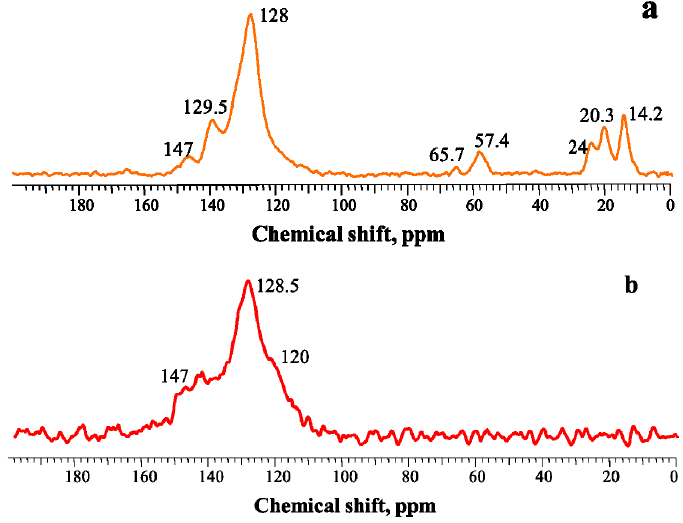
Figure 6. 13C CP/MAS NMR spectra of PAF ‐ 30 ‐ NiWS catalyst before ( a ) and after ( b ) the reaction.